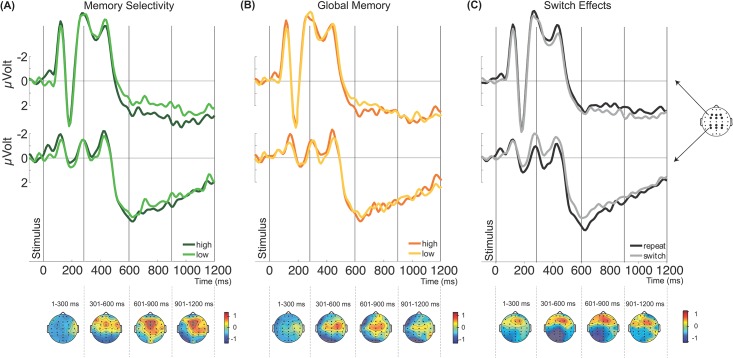
Stimulus-locked potentials for Memory Selectivity, Global Memory, and Switching, measured at the frontal electrodes F3, FZ, F4, FC3, FCZ, and FC4 (upper) and posterior electrodes CP3, CPZ, CP4, P3, PZ, and P4 (lower), as well as topographic maps.(A) Top: ERP waveforms for high and low memory selectivity trials, both time-locked to the onset of the stimulus. Bottom: The scalp topography of the average signal differences between high and low memory selectivity trials in steps of 300 ms starting with stimulus-onset. (B) Top: ERP waveforms for high and low global memory trials, both time-locked to the onset of the stimulus. Bottom: The scalp topography of the average signal differences between high and low global memory trials in steps of 300 ms starting with stimulus-onset. (C) Top: ERP wave forms for switch and repeat trials, both time-locked to the onset of the stimulus. Bottom: The scalp topography of the average signal differences between switch and repeat trials in steps of 300 ms starting with stimulus-onset. Figures show data collapsed across material and switching (A and B), and material (C).